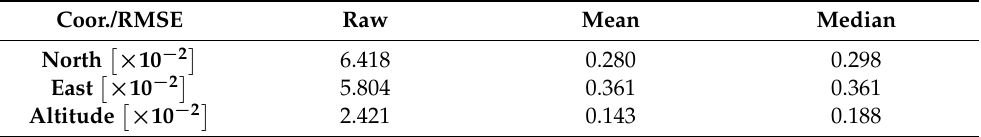
Table 5. RMSE value.